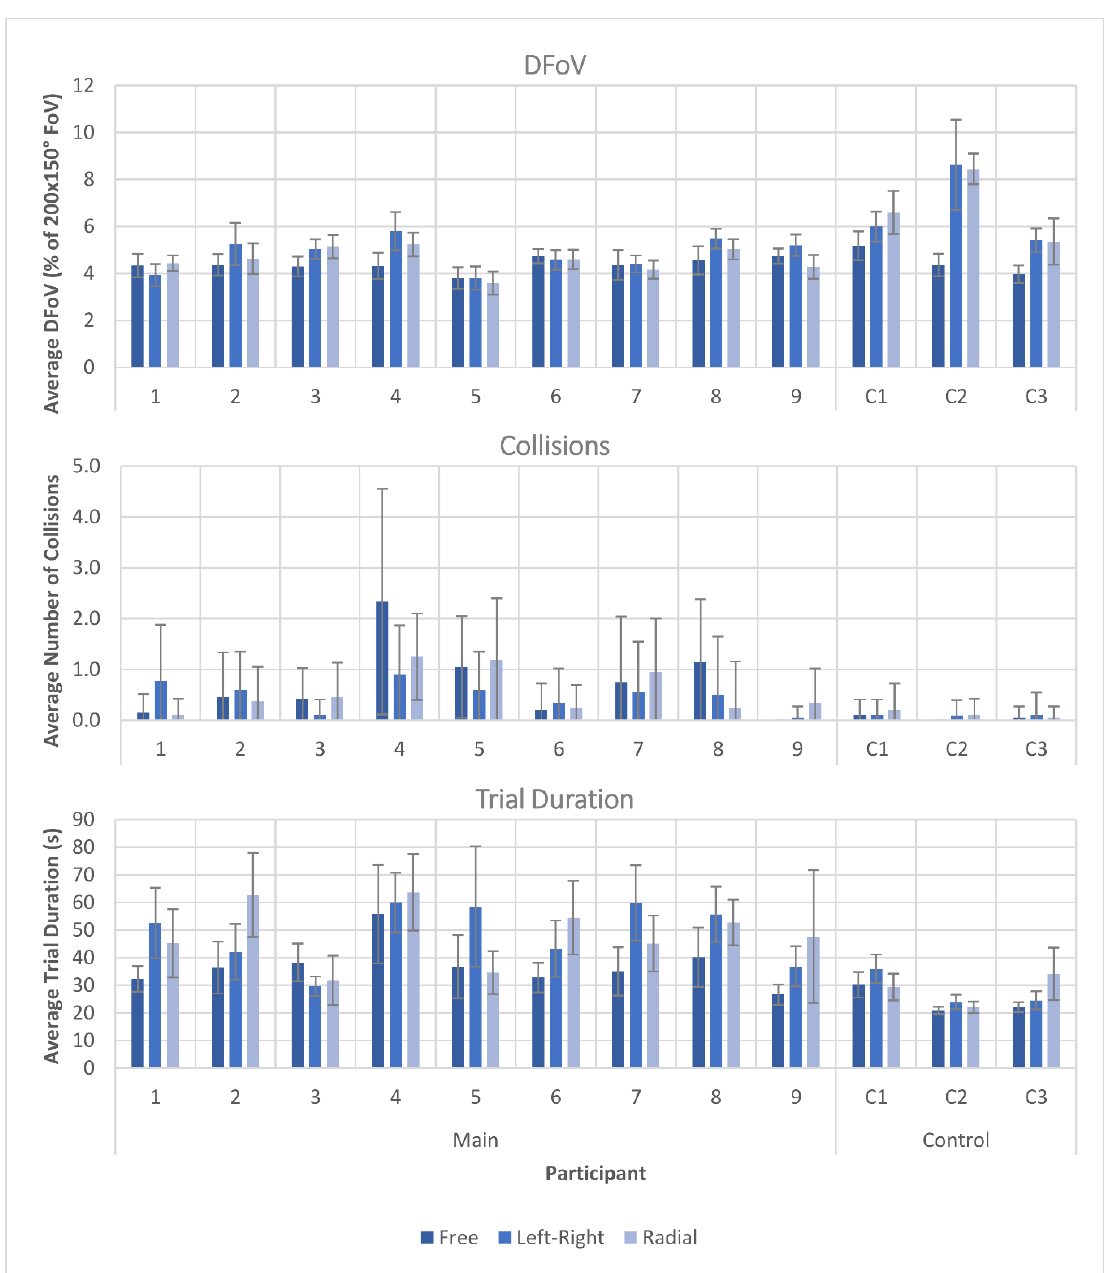
Figure A1. Comparison of DFoV, number of collisions, and trial duration in the navigation task between individual participants. Each bar shows the average of the results of 20 trials.